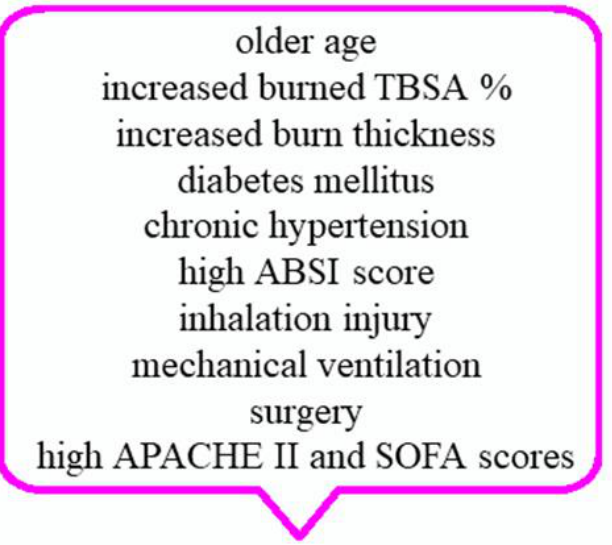
Figure 2. Main risk factors of burned-induced AKI. Notes: ABSI—the abbreviated burn severity index; APACHE II—acute physiology and chronic health evaluation II; SOFA—sequential organ failure assessment; TBSA—total body surface